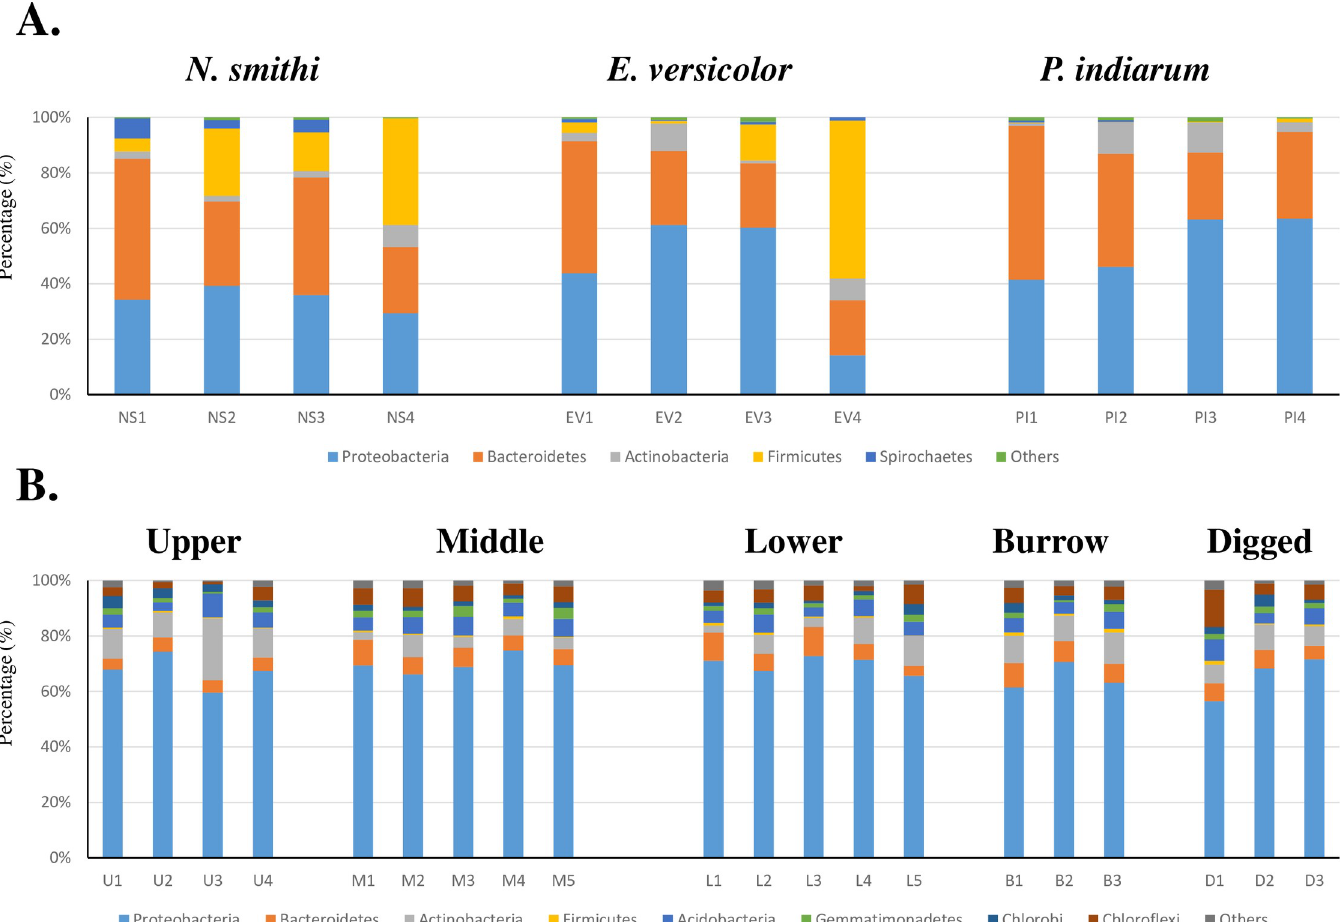
Fig 2. Phylum distribution with relative abundance. Tags are classified using a threshold of 97%. The bar indicates the relative abundance in each sample. A) Crab intestines. B) Sediment regions.